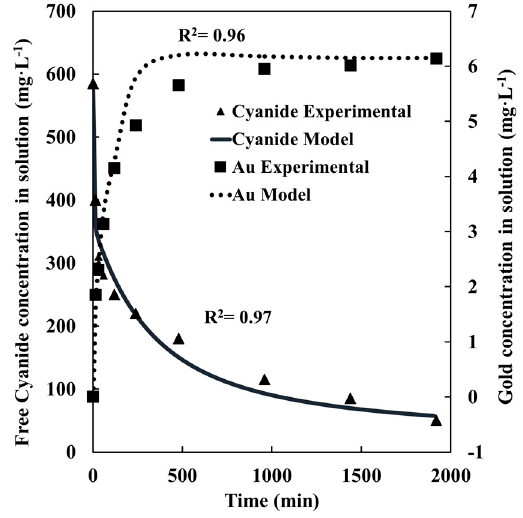
Figure 8. Free cyanide and gold concentrations in solution for the gold + pyrite + chalcopyrite system.